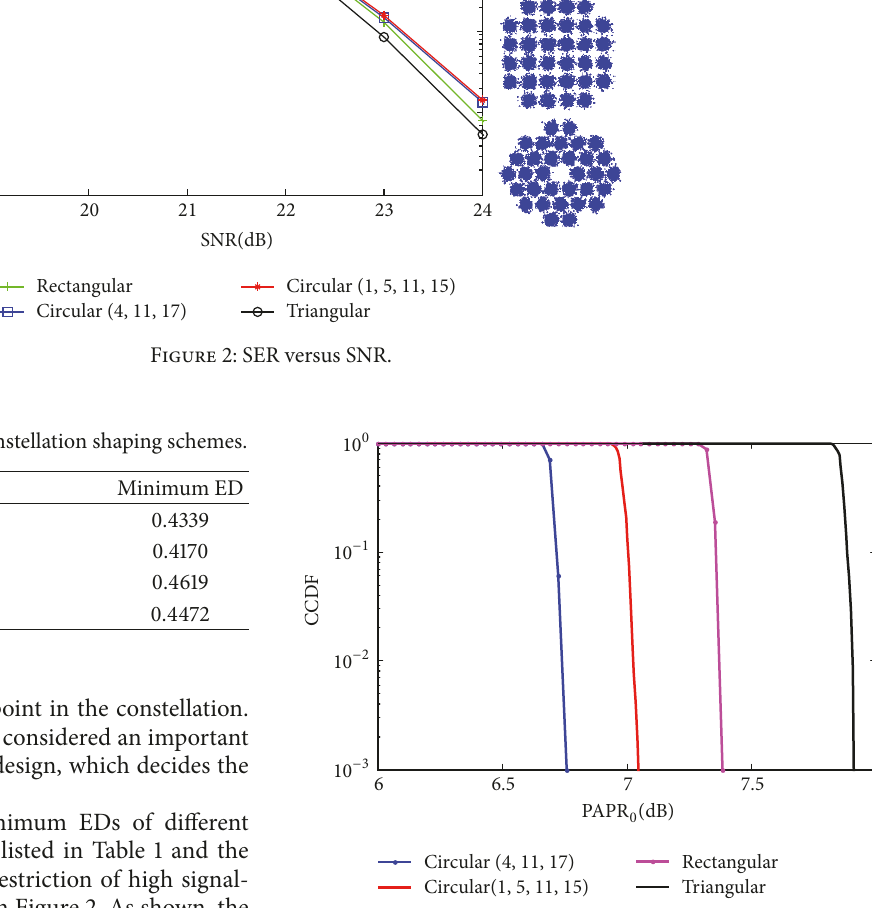
Figure 3: CCDF of PAPRs for different constellation shaping